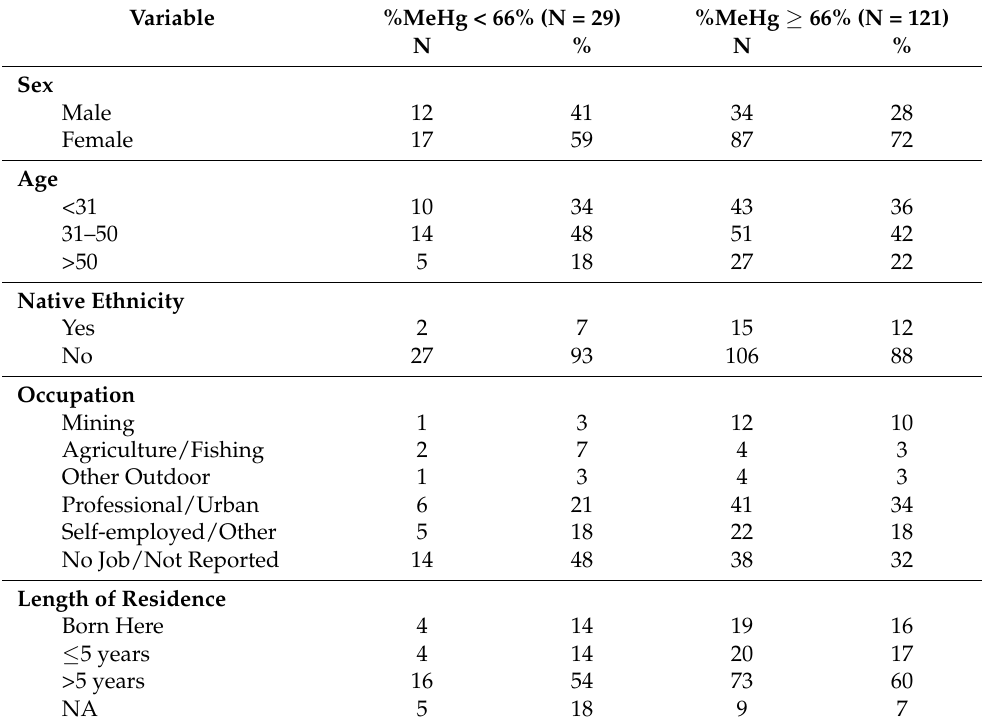
Table 2. Demographics of individuals within mining, separated by those with hair %MeHg < 66% and those with hair %MeHg ≥ 66%. Sex, age, nativity, and occupation were used as predictor variables in the logistic